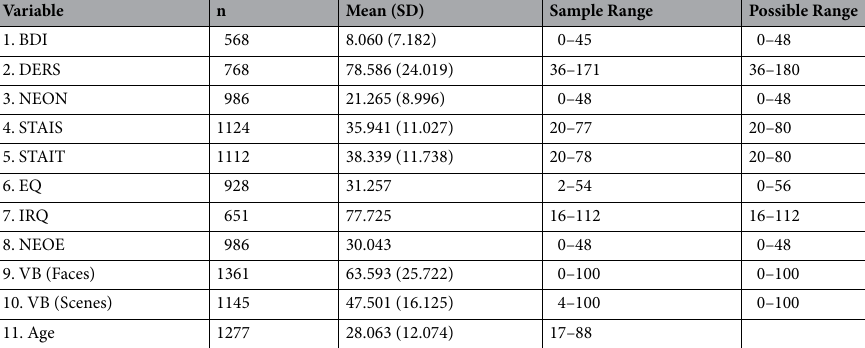
Table 3. Descriptive statistics of observed variables. BDI Beck Depression Inventory, DERS Difficulties in Emotion Regulation Scale, N E ON Neuroticism, STAIS State Anxiety, STAIT -Trait Anxiety, EQ Empathy Quotient, IRQ Interpersonal Regulation Questionnaire, NEOE Extraversion, VB Valence Bias-higher scores associated with a more negative